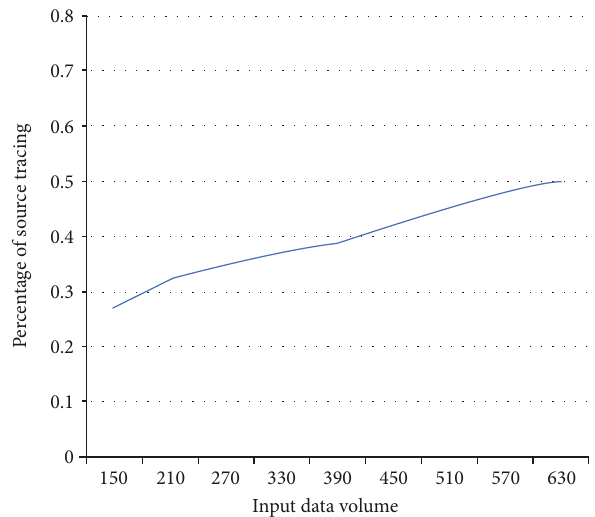
Figure 8: Percentage of source tracing results generation time in the entire execution.